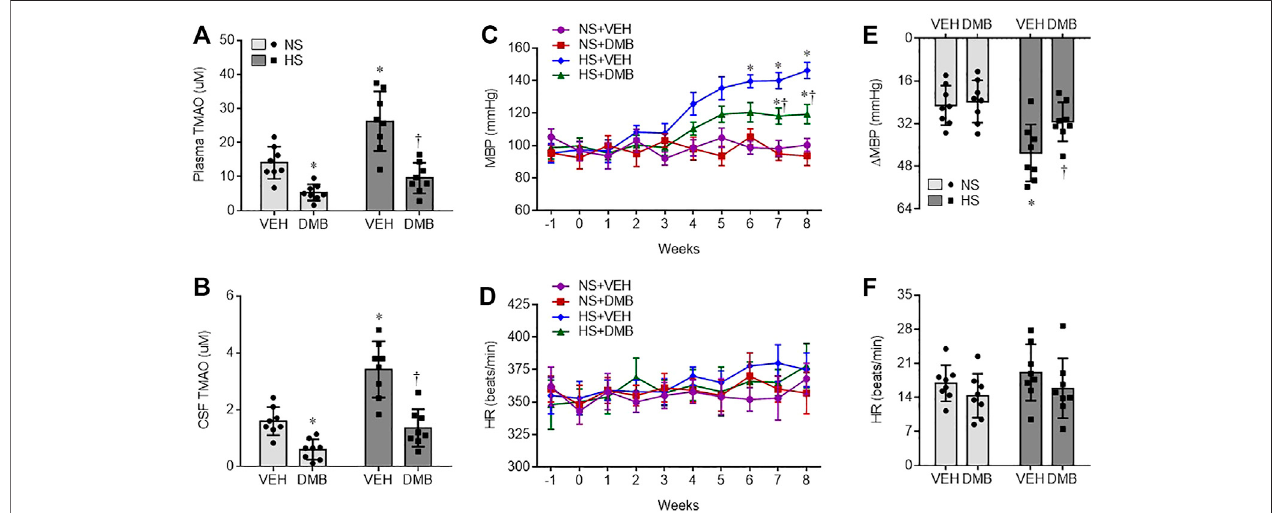
FIGURE 1 | Levels of trimethylamine N-oxide (TMAO) in plasma (A) and cerebrospinal fl uid CSF, (B) , and mean blood pressure MBP, (C) and heart rate HR, (D) , and maximal changes ( Δ ) in MBP (E) and HR (F) following administration of ganglionic blocker hexamethonium, in rats fed a normal salt (NS) diet or a high salt (HS) diet andsimultaneouslytreatedwithvehicle(VEH)or1.0%3,3-Dimethyl-1-butanol(DMB,aninhibitoroftrimethylamineformation).Alldataareexpressedasmean±SEM( n = 8 rats/per group). p p < 0.05 vs . NS + VEH; † p < 0.05, HS + DMB vs . HS +